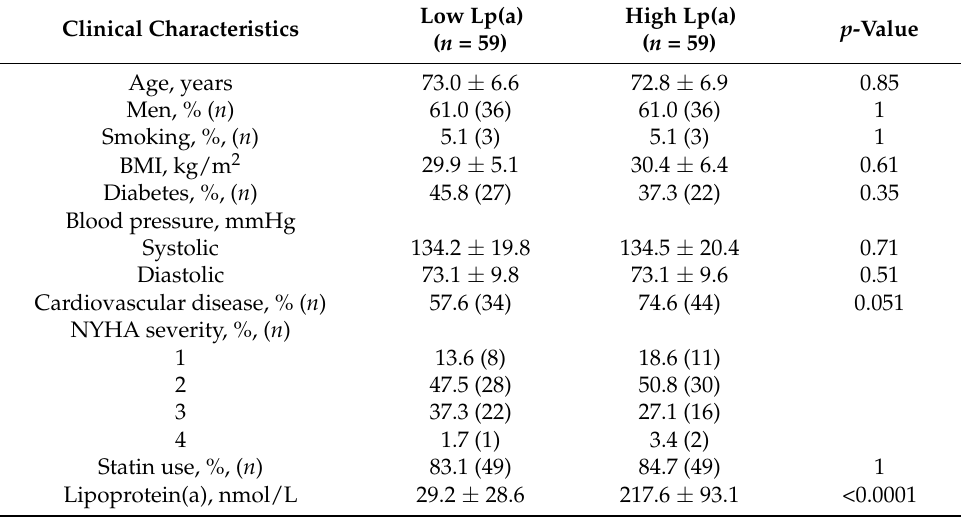
Table 3. Patient characteristics for the explanted valves